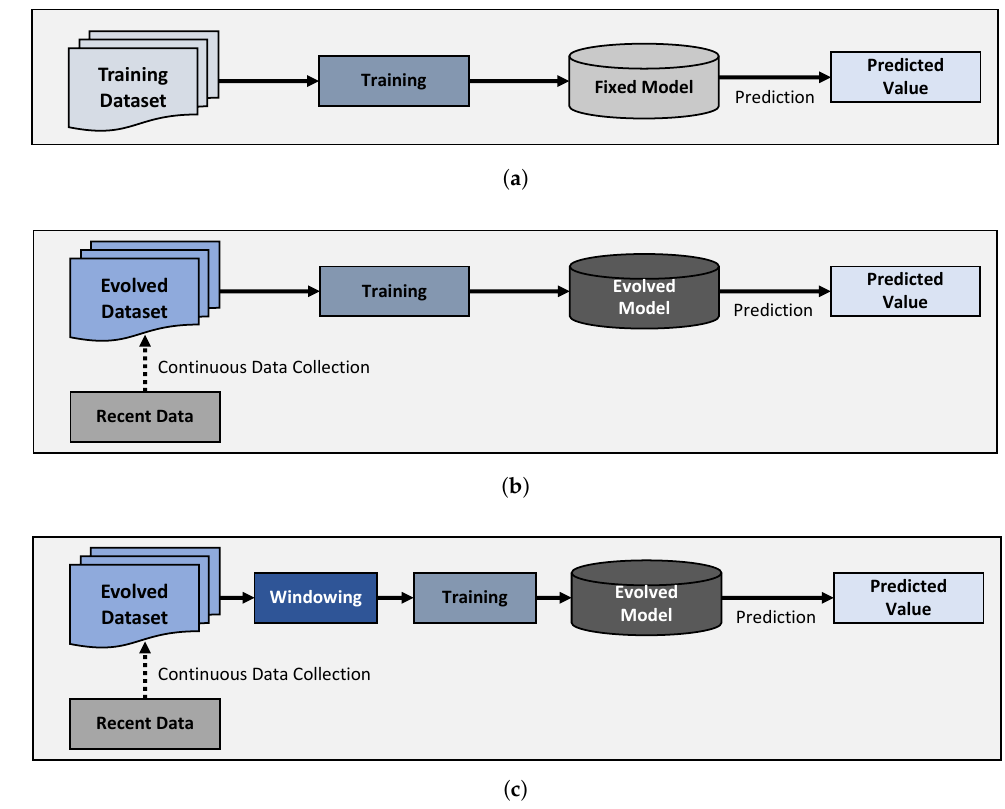
Figure 2. Three training methods: ( a ) batch learning; ( b ) plain online learning; and ( c ) windowing time-invariant online